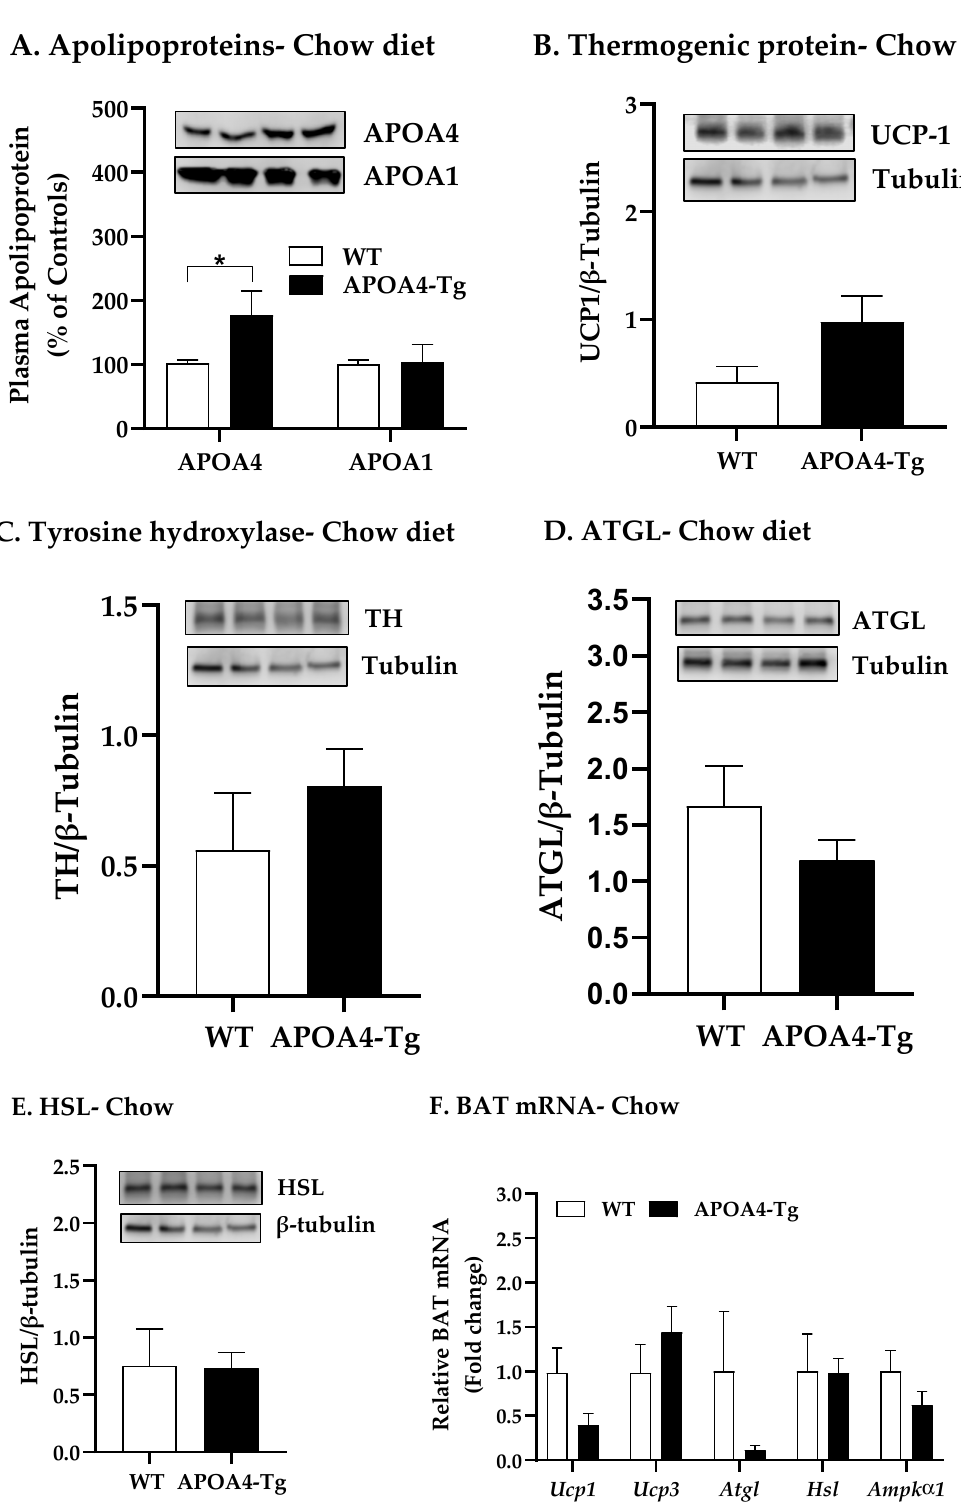
Figure 1. Levels of plasma apolipoproteins ( A ), thermogenic protein ( B ), tyrosine hydroxylase (TH) protein ( C ), adipose triglyceride lipase (ATGL) protein ( D ), hormone sensitive lipase (HSL) protein ( E ), and mRNA ( F ) in BAT of WT and APOA4-Tg mice when maintained on a chow diet at 21 °C. Plasma and BAT in 5 h fasted mice were collected. Plasma apolipoproteins in WT mice were considered as 100%. Data are expressed as mean ± SEM for 6–8 animals per group. Values with asterisks (*) represent significant differences relative to the WT mice ( p < 0.05).